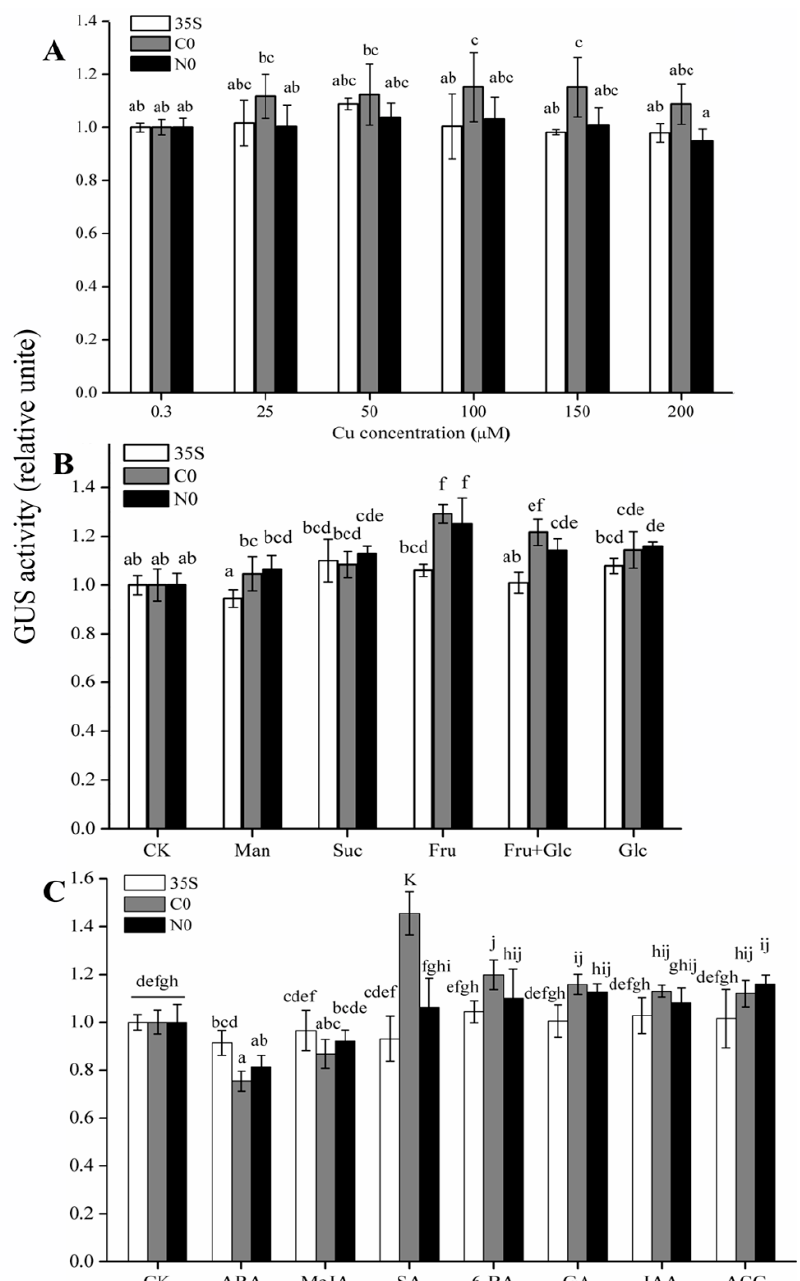
Figure 3. Relative GUS activity of full-length promoter constructs under different treatments. ( A ). Relative GUS activity in 35S, C0, and N0 lines following treatment with 0.3 µ M (control), 25 µ M, 50 µ M, 100 µ M, 150 µ M, or 200 µ M Cu 2+ (CuCl 2 · 2H 2 O). ( B ). Relative GUS activity in 35S, C0, and N0 lines following treatment with 1 ⁄ 2 MS liquid medium (CK) or 1 ⁄ 2 MS liquid medium containing sucrose (Suc, 200 mM), glucose (Glc, 200 mM), fructose (Fru, 200 mM), fructose+glucose (F+G, 100 mM, 1:1), and mannitol (Man, 200 mM, osmotic control). ( C ). Relative GUS activity in 35S, C0, and N0 lines following treatment with 20 µ M abscisic acid (ABA), 20 µ M cytokinin (6-BA), 20 µ M auxin (IAA), 20 µ M gibberellin (GA), 100 µ M ethylene precursor (1-aminocyclopropane-1-carboxylic acid, ACC), 100 µ M methyl jasmonate (MeJA), 100 µ M salicylic acid (SA), or sterile water (CK). Relative GUS activity is the GUS activity of each treated transgenic line relative to its control, and bars represent the mean ± SD. Different letters indicate significant differences ( p < 0.05) according to one-way ANOVA followed by Duncan’s test ( n =